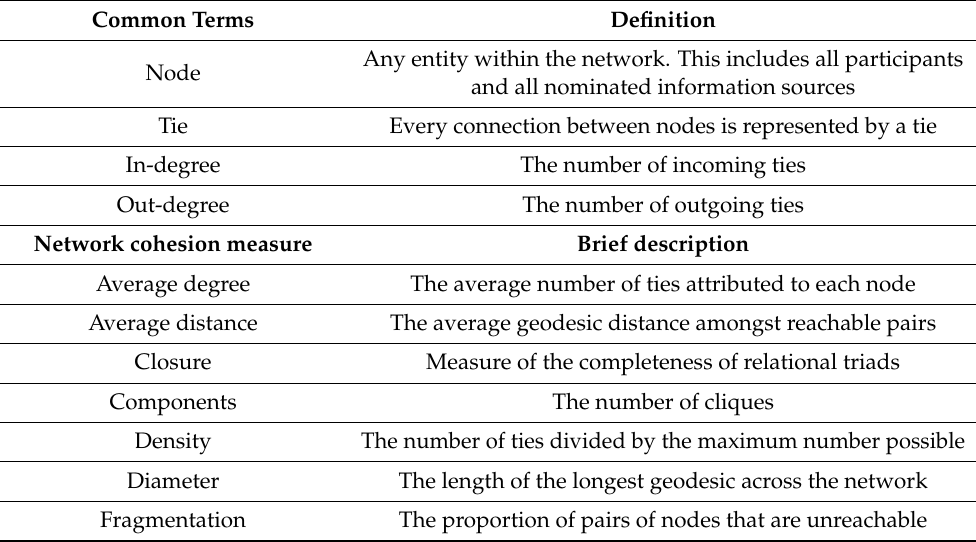
Table 3. Definitions of common network terms and description of network cohesion